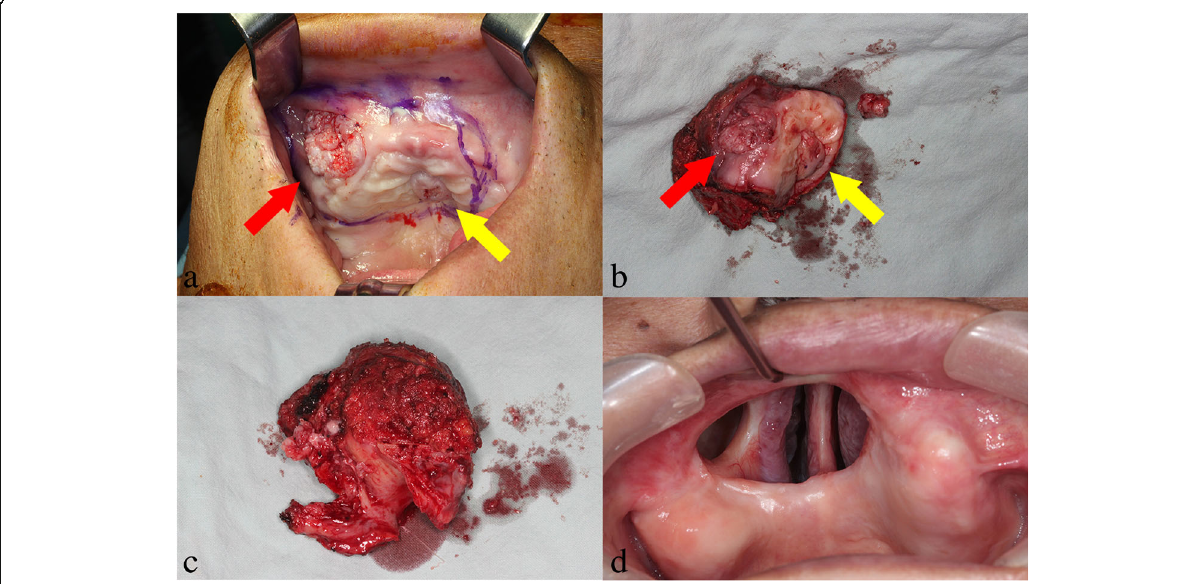
Fig. 5 Preoperative and postoperative clinical photograph. a Pre-operative image. b Excisional specimen (the right side of the maxilla, red arrow; the palatal side, yellow arrow). c Verrucous proliferation pattern can be seen on the surface of the lesion inside the bone. d At 2-years post-surgery, there is no recurrence of